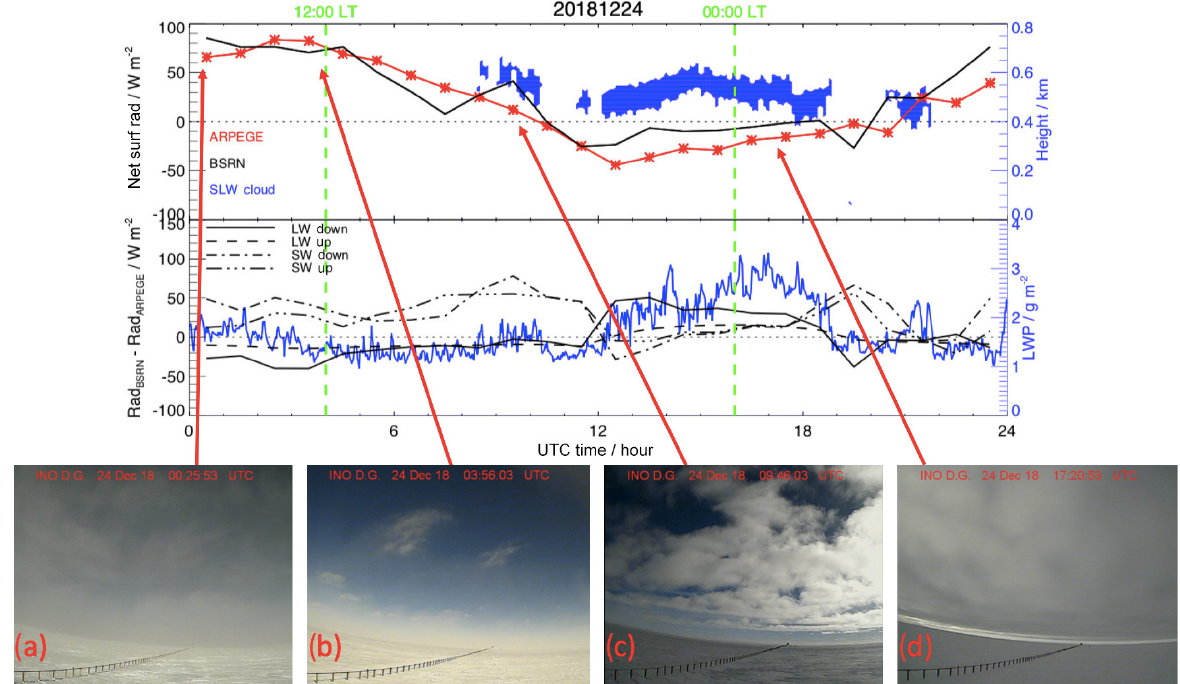
Figure 15. Top: diurnal variation in the net surface radiation (Wm − 2 ) observed by BSRN (black solid line) and calculated by ARPEGE-SH (red crossed line) on 24 December 2018 in UTC time. Superimposed is the SLW cloud height (blue) deduced from the lidar. Middle: diurnal variation in the difference between surface radiation (Wm − 2 ) observed by BSRN and calculated by ARPEGE-SH on 24 December 2018 for longwave downward (black solid), longwave upward (black dashed), shortwave downward (black dashed dotted), and shortwave upward (black dashed triple dotted) components. Superimposed is LWP (blue) measured by HAMSTRAD. Bottom: four webcam images show the cloud coverage at (a) 00:25UTC and (b) 03:56UTC (cirrus clouds, no SLW cloud), (c) 09:46UTC (SLW cloud), and (d) 17:20UTC (SLW cloud). Two vertical green dashed lines indicate 12:00 and